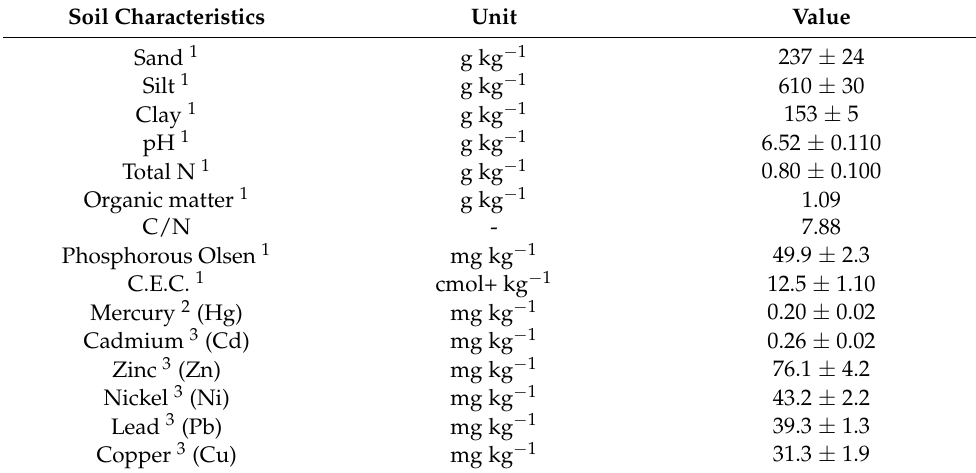
Table 1. Main soil characteristics of the vineyard at the beginning of the experiment. Soil Characteristics Unit Value Sand